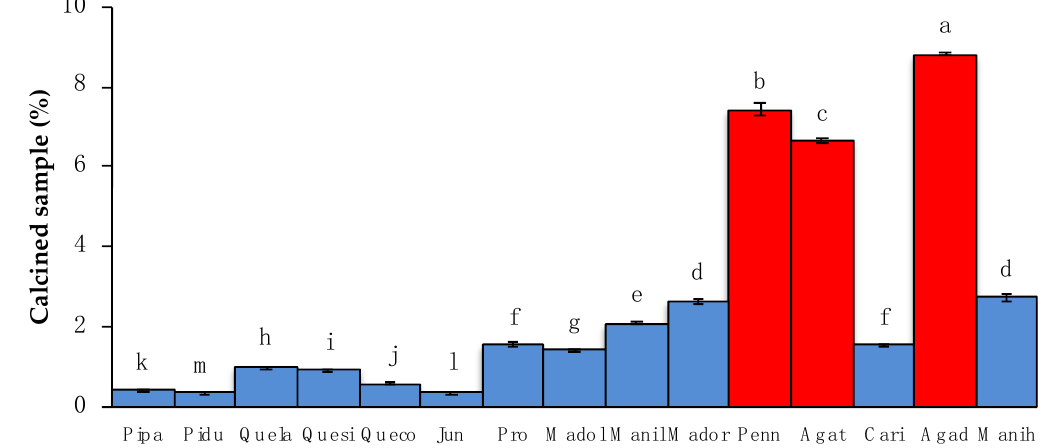
Figure 10. Percentage of calcined sample of the BioSlag test. The lines above the bars show the standard deviation, the species with different letters are statistically different ( p < 0.05). The bars in red color correspond to biomass pellets with high fusibility